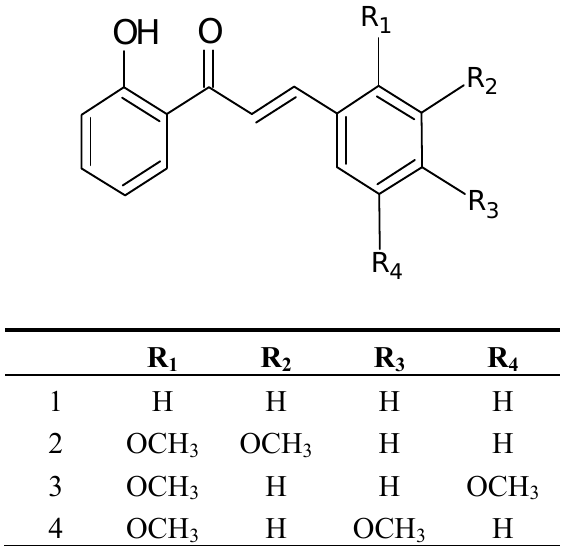
Figure 1. Structures of the studied chalcones.